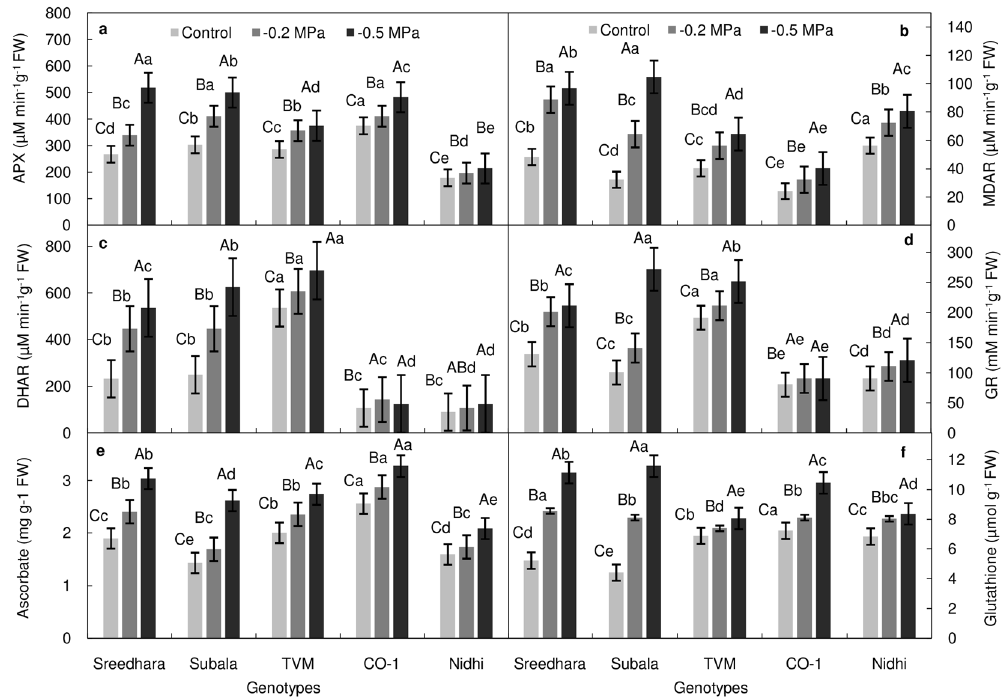
Figure 5. ( a–f) Effect of in vitro PEG mediated osmotic stress on ASA–GSH cycle of Chinese potato genotypes. ( a ) ascorbate peroxidase (APX, µ M min –1 g –1 FW), ( b ) monodehydro ascorbate reductase (MDAR, µ M min –1 g –1 FW), ( c ) dehydro ascorbate reductase (DHAR, µ M min –1 g –1 FW), ( d ) glutathione reductase (GR, mM min –1 g –1 FW), ( e ) ascorbate (ASA, mg g –1 FW), and ( f ) reduced glutathione (GSH, µ mol g –1 FW). Values are the mean of three replicates and bars represent standard error of means. Different letters in upper case represent significant differences between the treatments (control, –0.2 MPa and –0.5 MPa) in the genotypes and lower case represents significant difference among the genotypes under each treatment according to Tukey’s